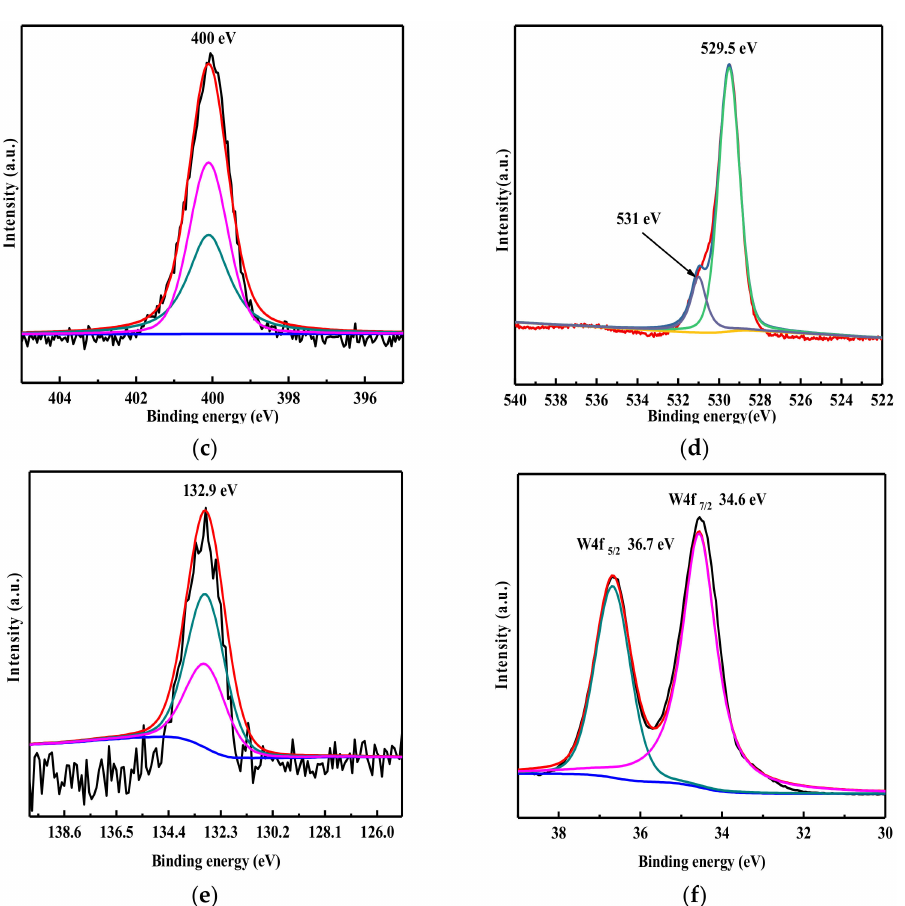
Figure 2. XPS spectra of [C 2 (MIM) 2 ]PW 12 O 40 ; ( a ) Survey of the catalyst; ( b ) C 1s; ( c ) N 1s; ( d ) O 1s; ( e ) P 2p; ( f ) W